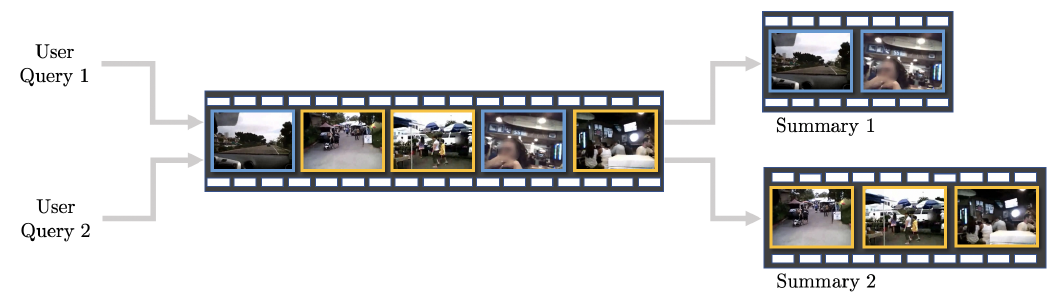
Figure 1. The illustration of the query-conditioned video summarization task. Given a user query, query-conditioned video summarization aims to predict a summary that is relevant to the query in a concise manner. Summary 1 and Summary 2 are two summarization results for the same video but for different user